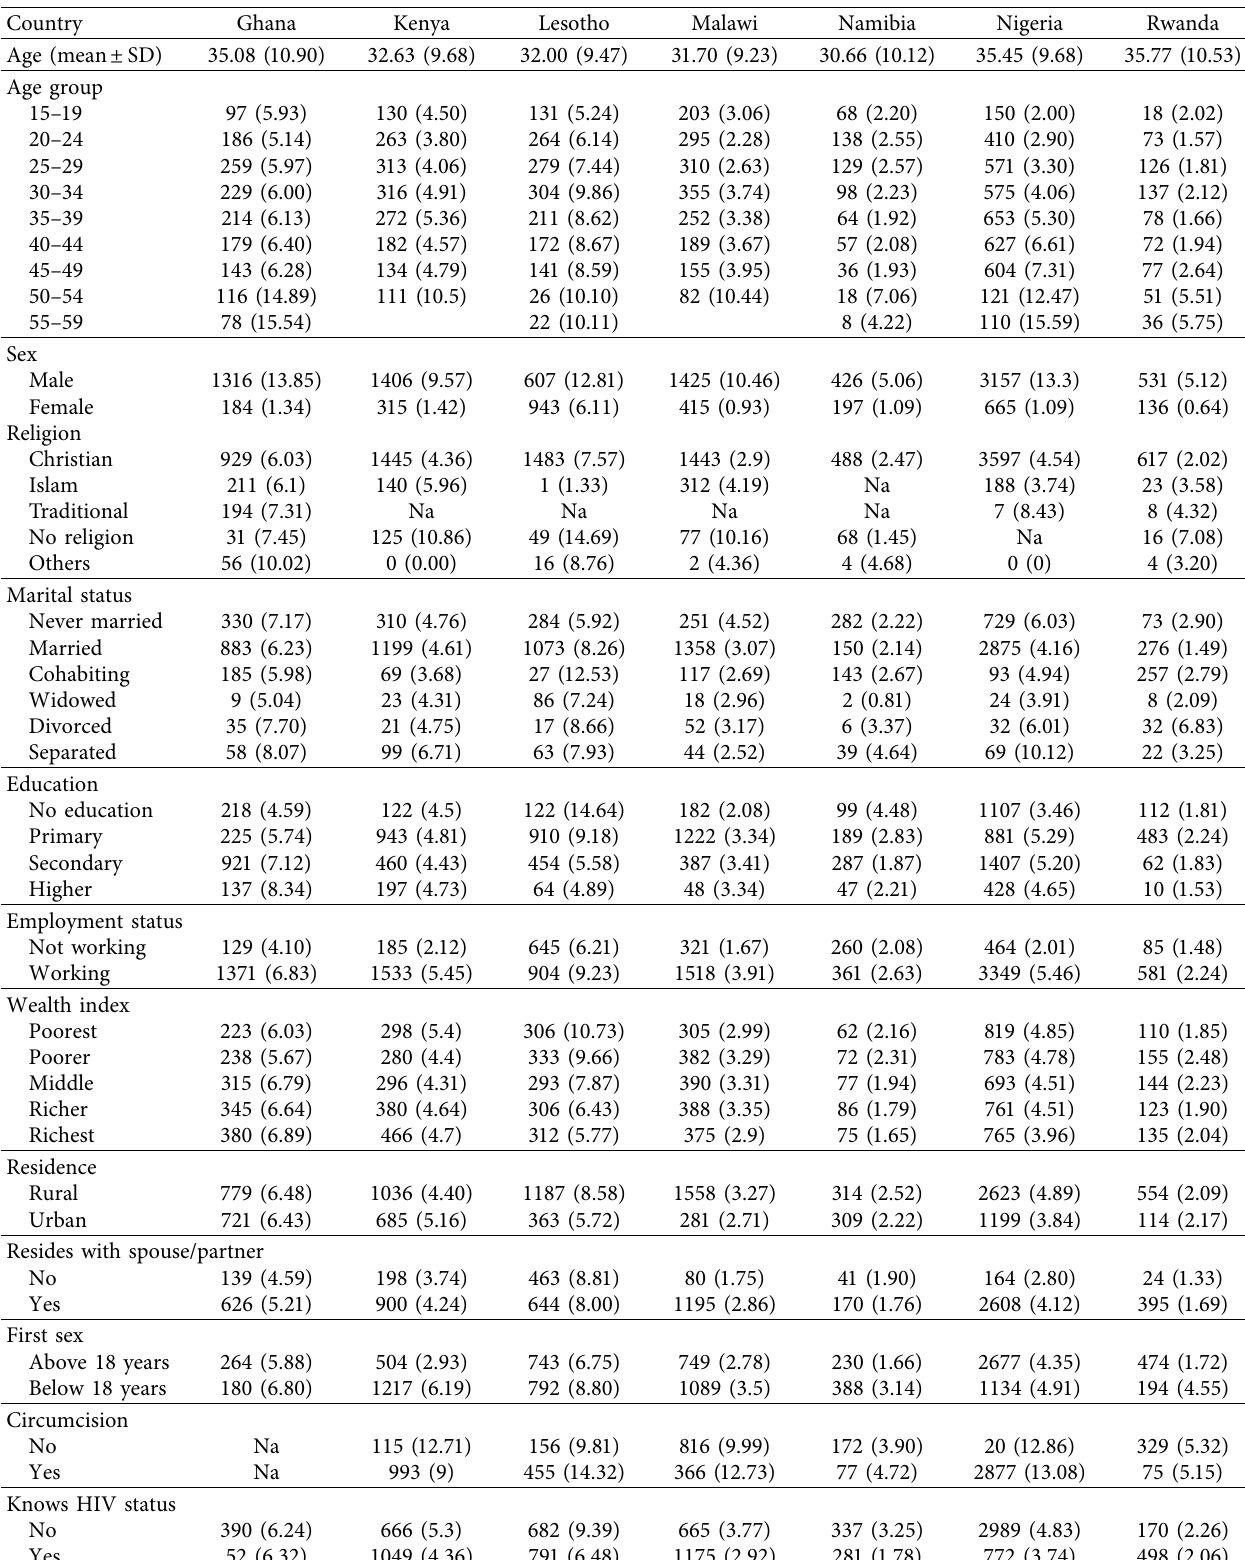
Table 2: Frequency and percentage distribution of respondents practicing higher-risk sexual behavior from the country-specific pooled dataset (periods